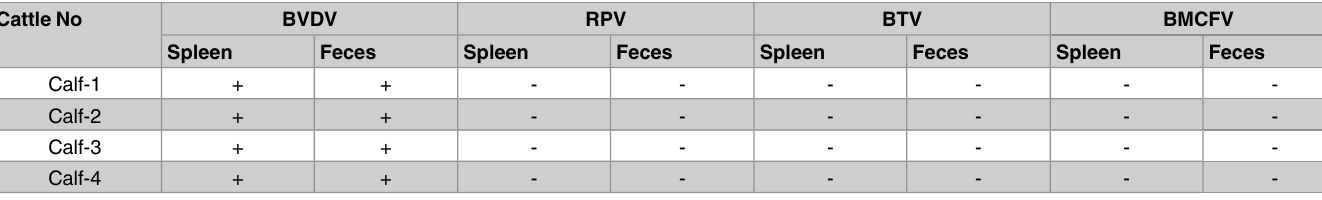
Table 4. Detection of BVDV viruses from sick cattle with RT-PCR. Cattle No Calf-1 Calf-2 Calf-3